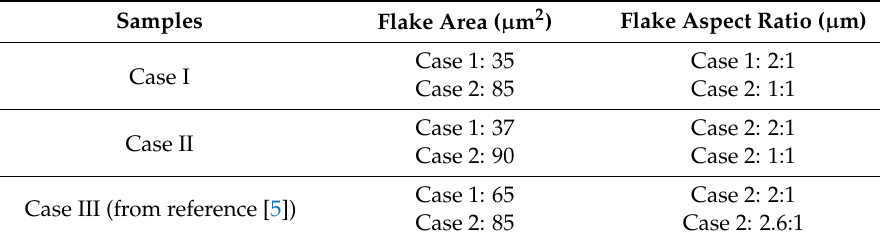
Table 2. Measured GP flakes of Case I, Case II and Case